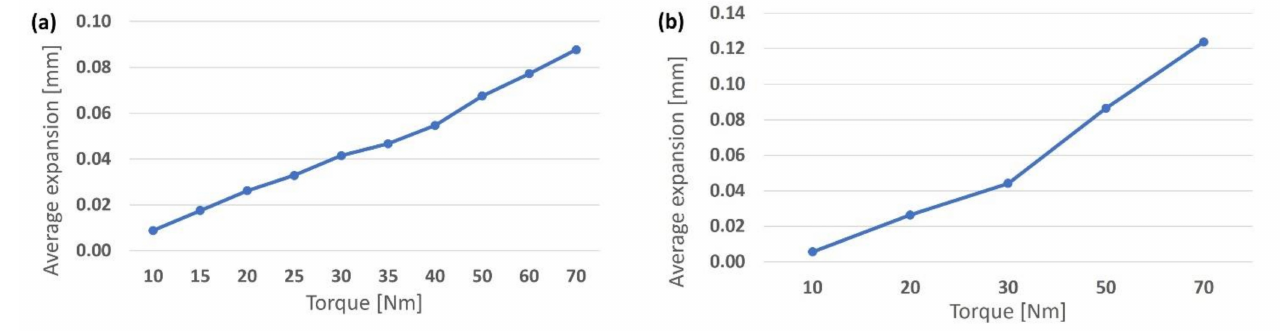
Figure 13. Test 1b—Average ring deformations of bearing rings on ( a ) non-lubricated and ( b ) lubri- cated double